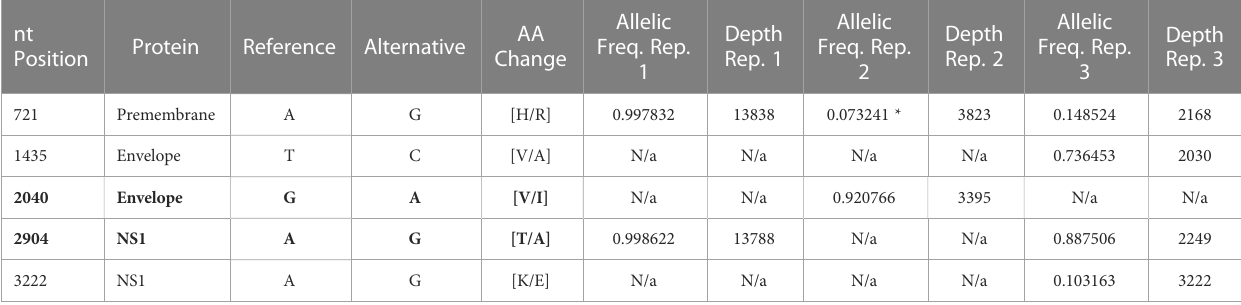
TABLE 3 Variants identi fi ed in passaged Zika virus (ZIKV)